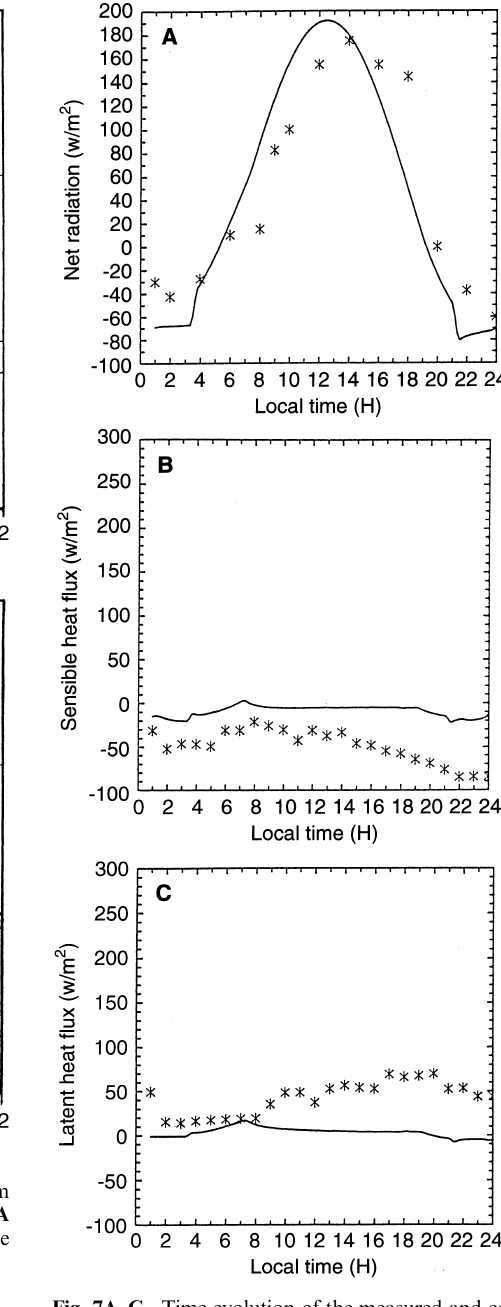
Fig. 7A–C. Time evolution of the measured and computed values of A the net radiation, B the sensible heat flux, and C and the latent heat flux on July 12 from 0000 LST to 2400 LST. The stars correspond to observations at